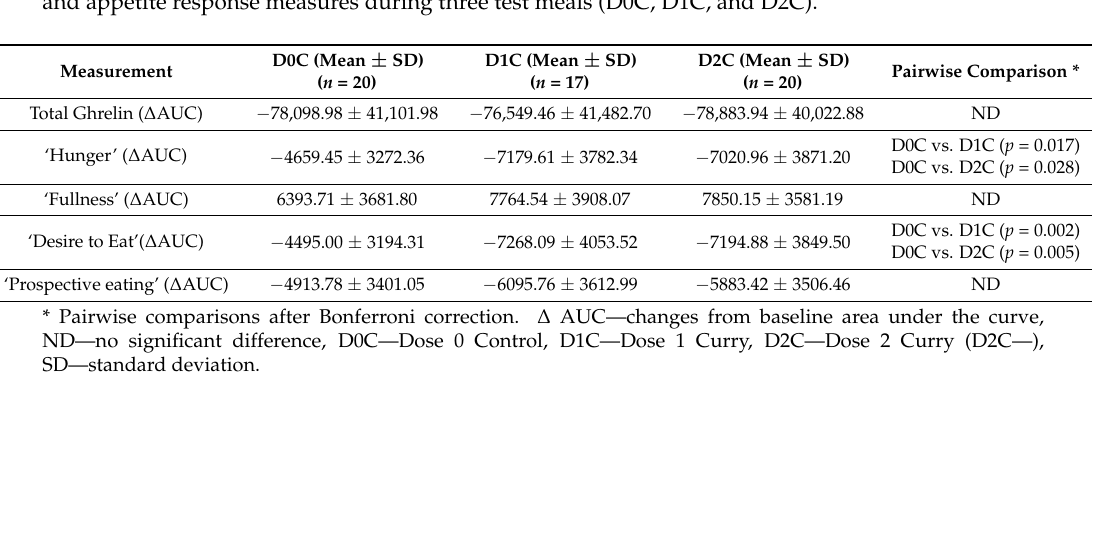
Table 1. Postprandial changes from baseline ( ∆ AUC) over 3 h periods in plasma ghrelin concentration and appetite response measures during three test meals (D0C, D1C, and